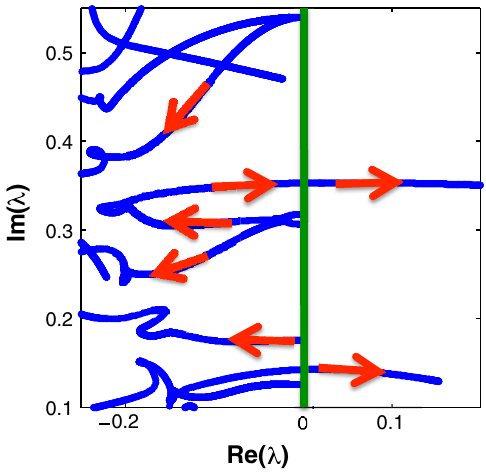
FIG. 3. Eigenvalue trajectories in the complex plane as g increases from zero. At g ¼ 0 , the system is Hermitian and the eigenvalues are real. The red arrows denote the motion of the eigenvalues in the complex plane as the gain-loss amplitude g